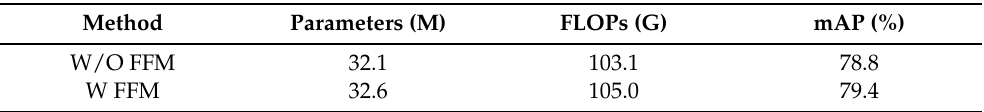
Table 7. Ablation study results of the proposed method with and without the proposed feature fusion module (FFM) for the PASCAL VOC 2007 test